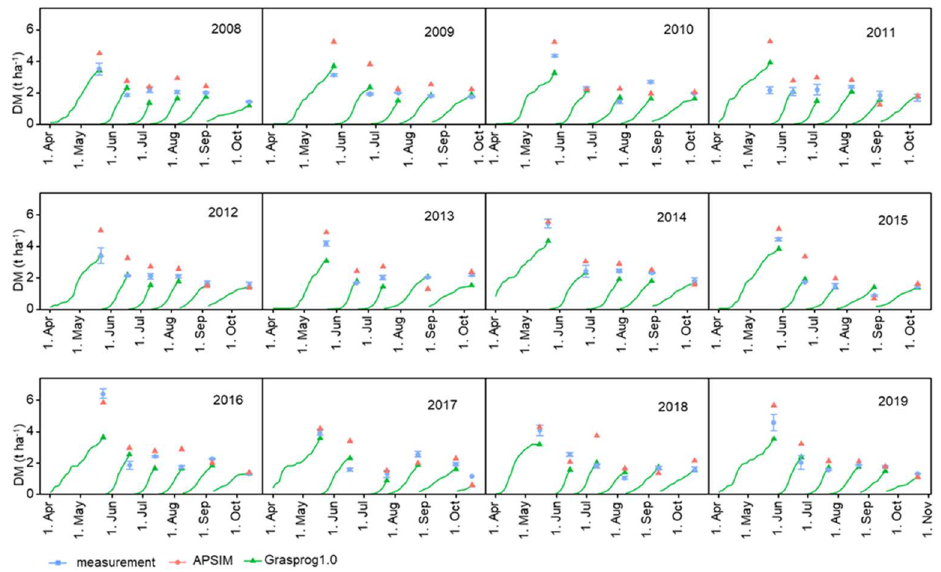
Figure 7. Measured grass dry matter (DM) for different cuts and years for Osterseeon, Germany. The predictions by GrasProg1.0 and APSIM are also shown.